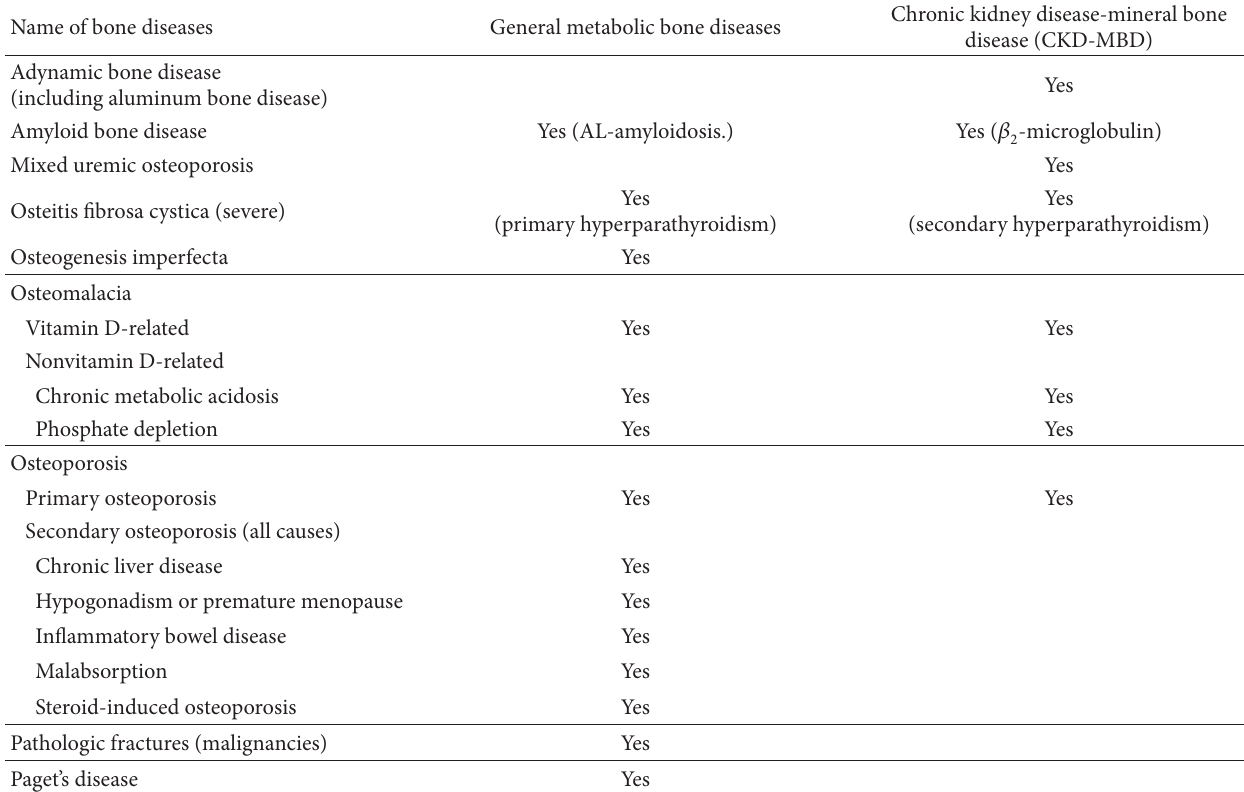
Table 1: Bone diseases may associate with fragility fractures (low trauma